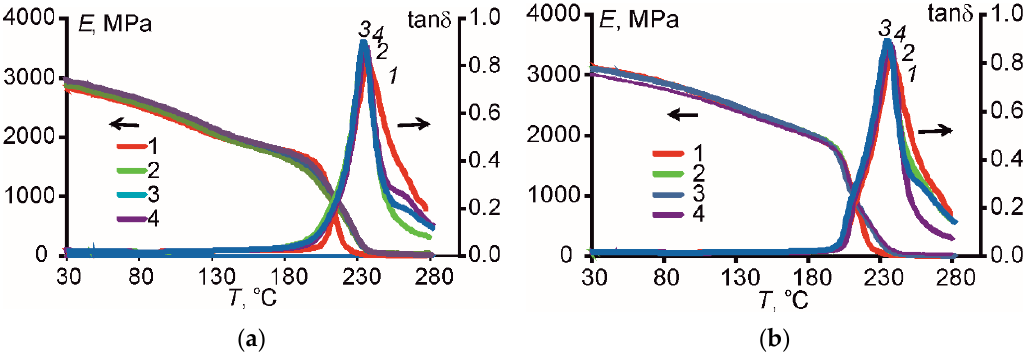
Figure 9. Storage modulus ( E ’) and loss factor (tan δ ) of the epoxy ( 1 ) and epoxy filled with 0.05 wt. % of CNT ( 2 ), 0.1 wt. % of HN ( 3 ), and 0.3 wt. % of CNF ( 4 ) vs. temperature ( a ) after water absorption at 70 °C and ( b ) after heating at 70 °C.